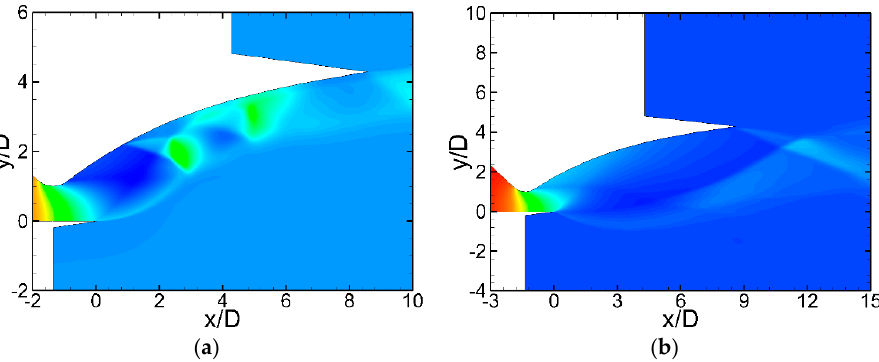
Figure 6. Typical iso-density contours of wet steam flow. ( a ) p 0 = 7 bar, T 0 = 436 K; and ( b ) p 0 = 32 bar, T 0 = 510 K.